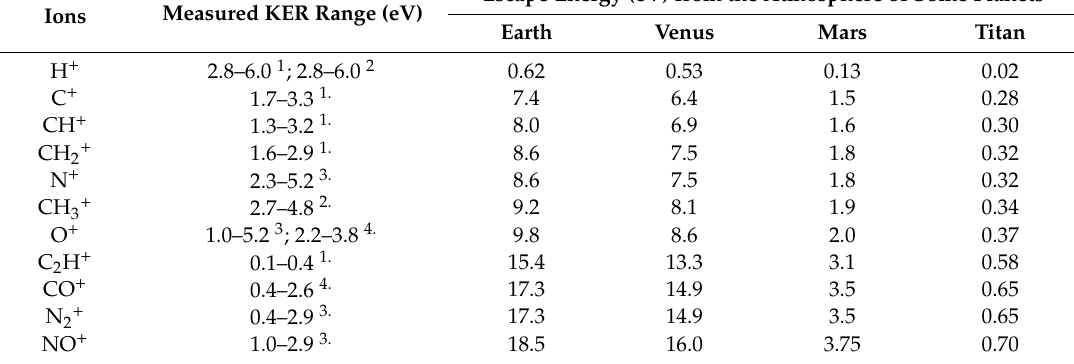
Table 1. The measured KER (eV) for some ionic species generated by Coulomb explosion of C 2 H 22 + , CO 22 + , N 2 O 2 + and C 2 H 5 NO 2 + (from N-methylformamide) metastable dications of astrochemical interest compared with their escape energy (eV) from the atmosphere of various planets of the Solar system and of Titan (the largest moon of Saturn) evaluated at the exobase [7]. Escape Energy (eV) from the Atmosphere of Some Planets Ions Measured KER Range (eV) Earth Venus Mars Titan H